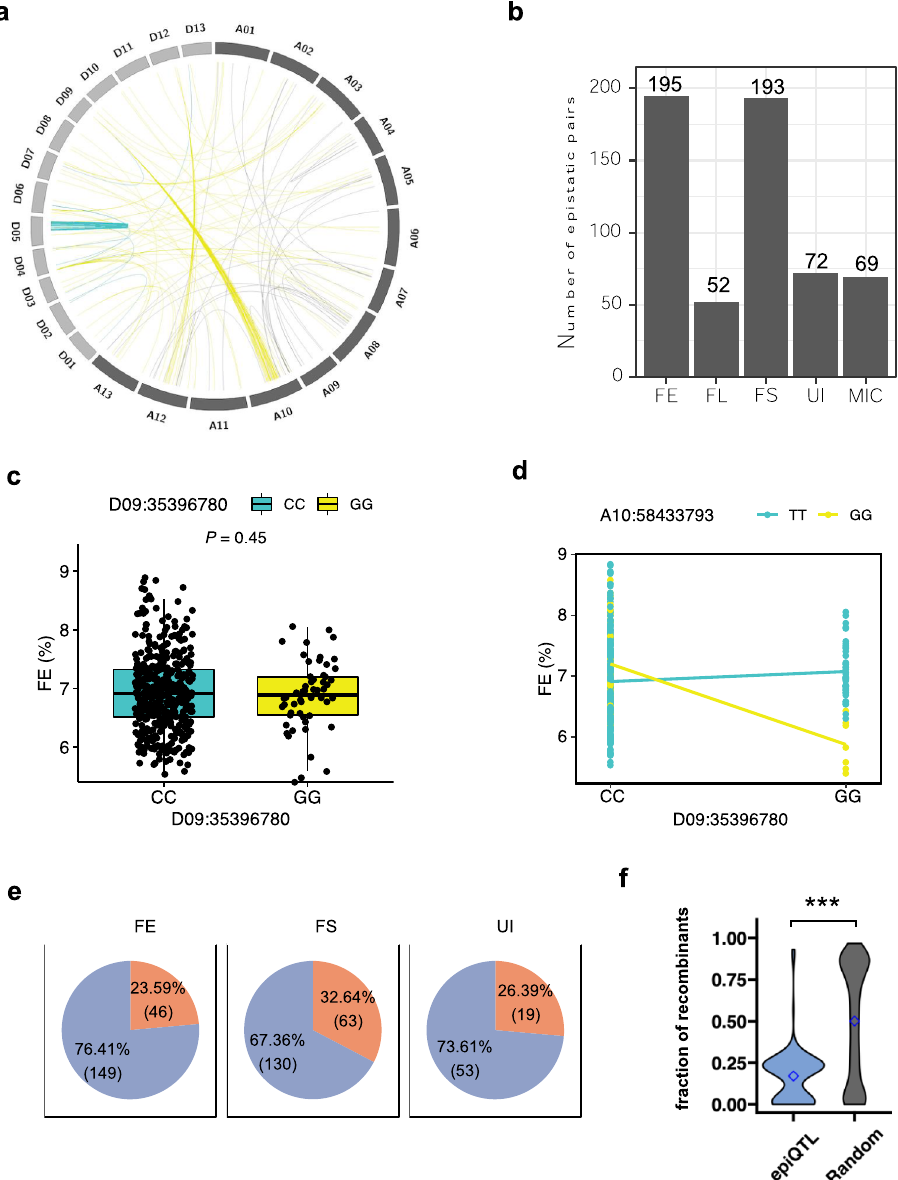
Supplementary Fig. 4. Gray line, AA epistasis; blue line, DD epistasis; yellow line, AD epistasis. b The number of signi fi cant epistasis for different traits. c Boxplot of FE in two genotypes at SNP D09:35396780 locus. t -test shows there is no difference between the two genotypes. d Interaction plot for epistasis between two SNPs (D09:35396780 × A10:58433793). This plot displays the relationship between D09:35396780 and A10:58433793 at two values of A10:58433793. e Different ratios for identi fi ed epiQTL linked with signi fi cant SNPs identi fi ed by sGWAS. Orange color, epiQTL linked with a signi fi cant SNP; blue color, neither of two interacting loci linked with any signi fi cant SNP. f Fraction of recombinants encompassing interacting pairs of loci between epiQTL and random distal